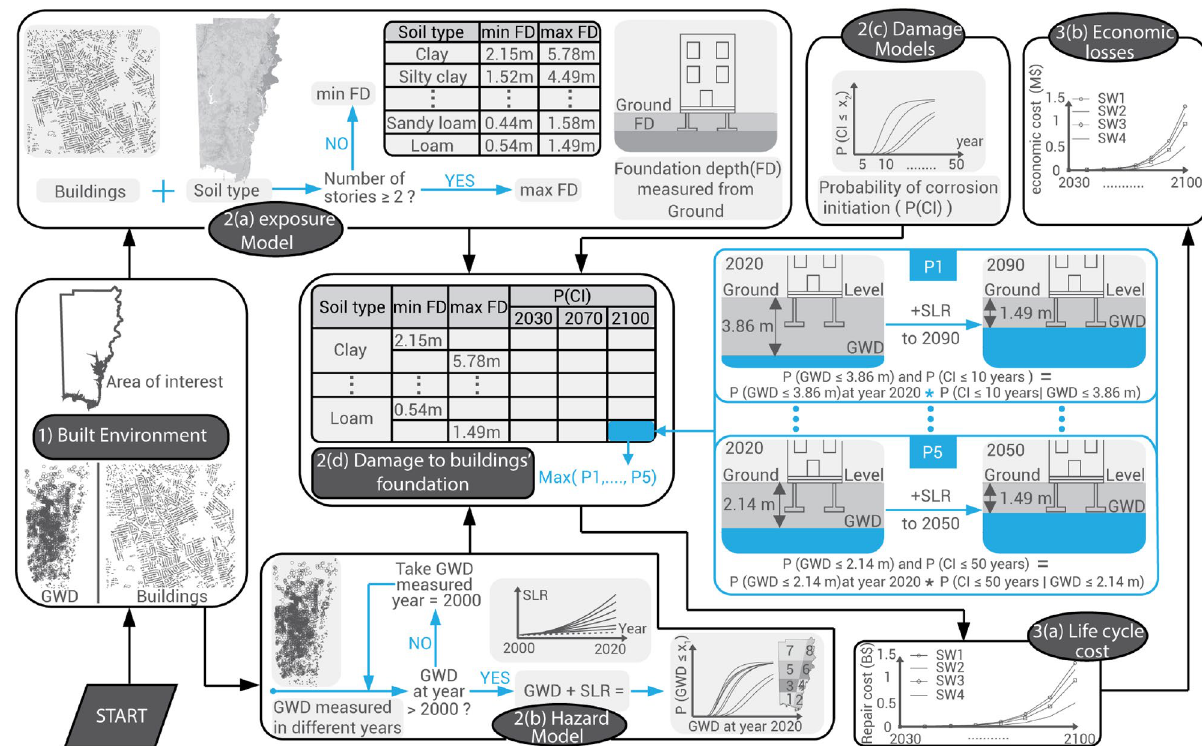
Figure 3. Building foundations deterioration assessment